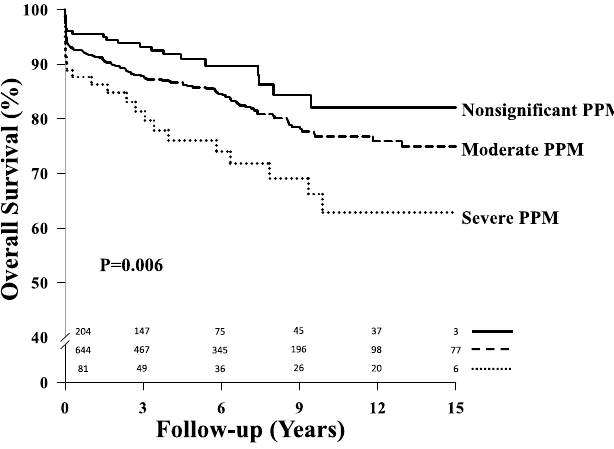
Figure. 13 Example of a chart provided by the manufacturers for the risk assessment of prosthesis-patient mismatch. The chart gives the projected indexed effective orifice areas (EOA-I) for the different level of patient’s body surface area (left-hand side) and the different prosthesis sizes (top of the chart) of a given model of prosthesis(hypotheticalmodelinthisexample).GreencellsindicatethattheprojectedEOA-Iis > 0.85cm 2 /m 2 , yellow cells indicate borderline values and red cells, indicate that there is a risk of mismatch. (Reproduced with permission from [109]).